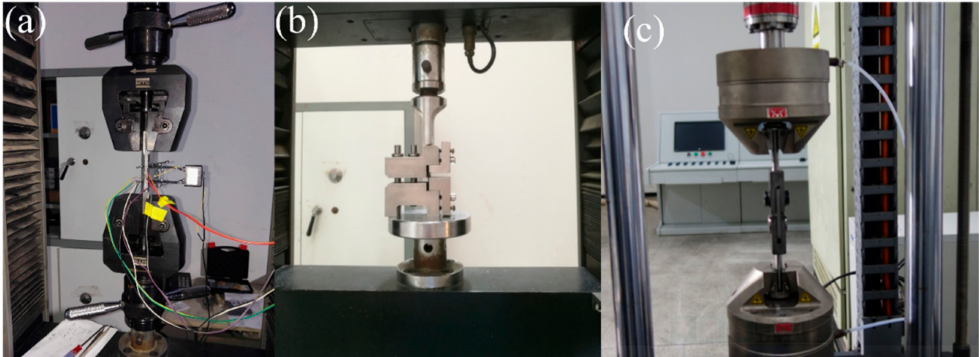
Figure 1. Mechanical tests of C/SiC composite and pins. ( a ) Tensile; ( b ) interlaminar shear; and ( c )